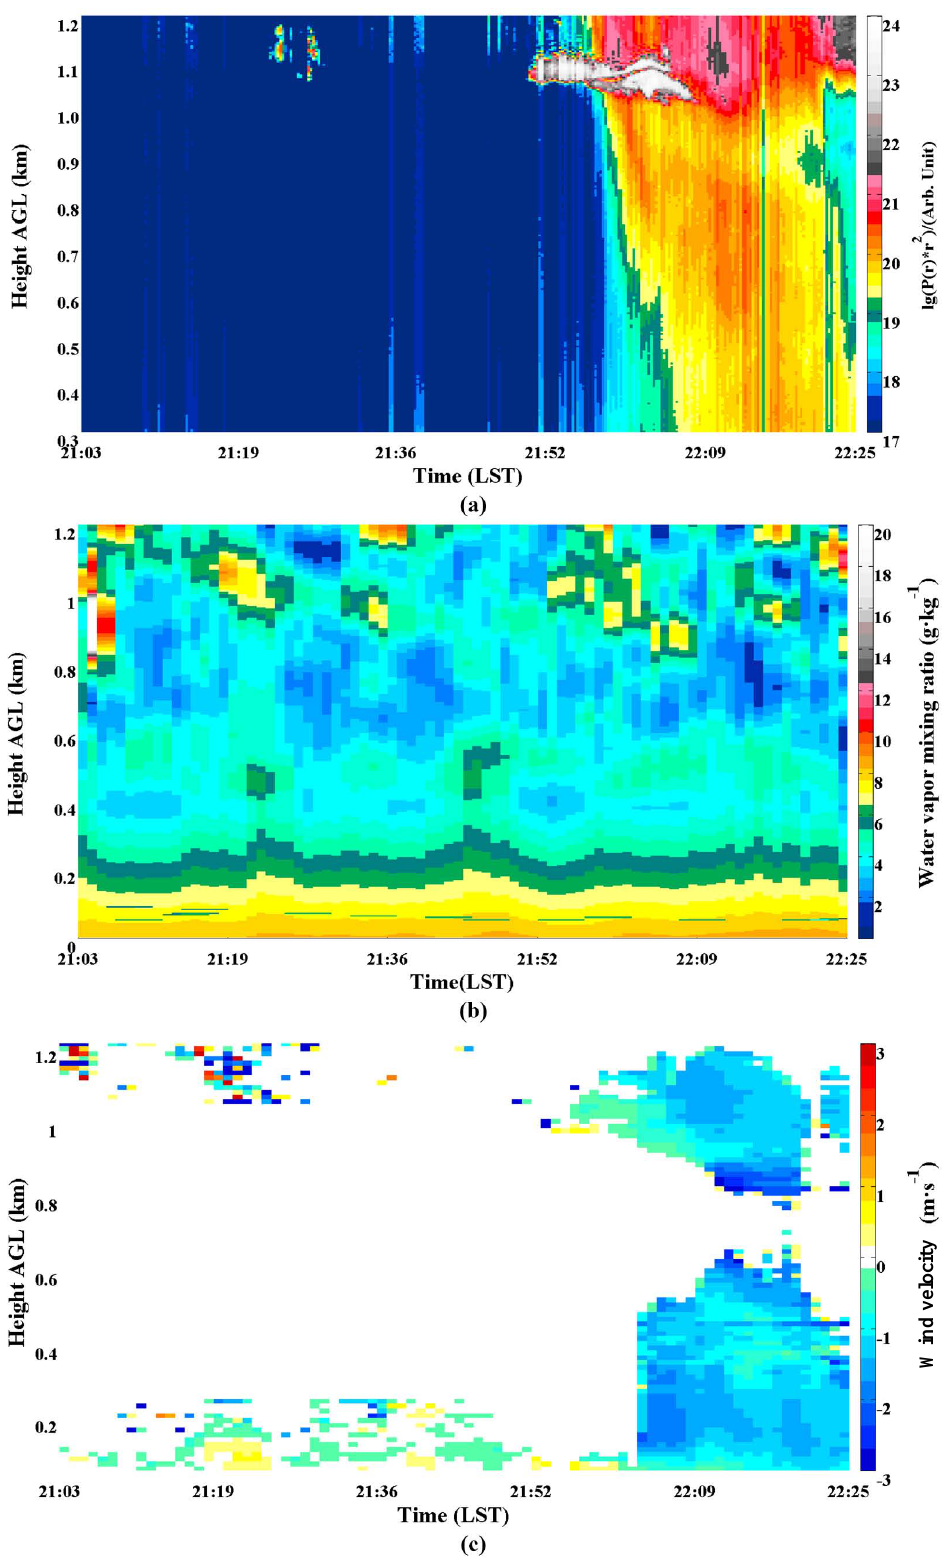
Figure 9. (a) Time serials of range correction signal measured by WACAL from 21:03 to 22:25 LST; (b) time serials of combined water vapor mixing ratio measured by WACAL and radiometer from 21:03 to 22:25LST; (c) time serials of vertical velocity profile from 21:03 to